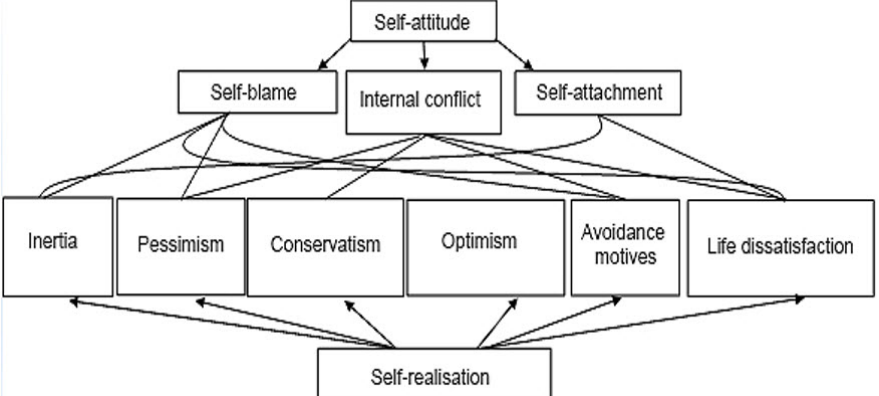
Figure 3. Correlations of components of self-attitude and self-realization in students with a negative- rigid